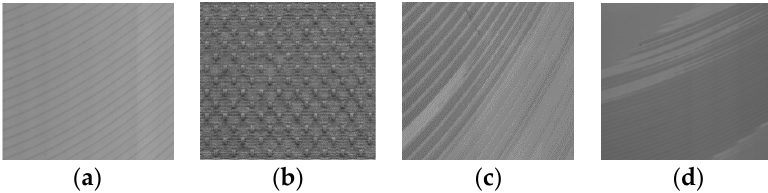
Figure 2. Structural textures examples. ( a ) Milled surface of aluminum ingot, oriented, homogeneous; ( b ) Fabric, isotropic, homogeneous; ( c , d ) Milled aluminum ingot surface, inhomogeneous.